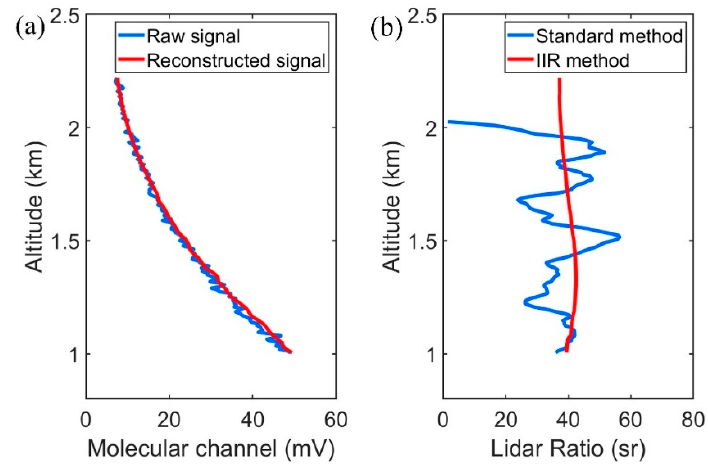
Figure 9. Results of the observations from ZJU HSRL. ( a ) The profiles of the reconstructed signal and the raw signal, respectively. ( b ) The profiles of the lidar ratio obtained by the standard method and the IIR method, respectively.